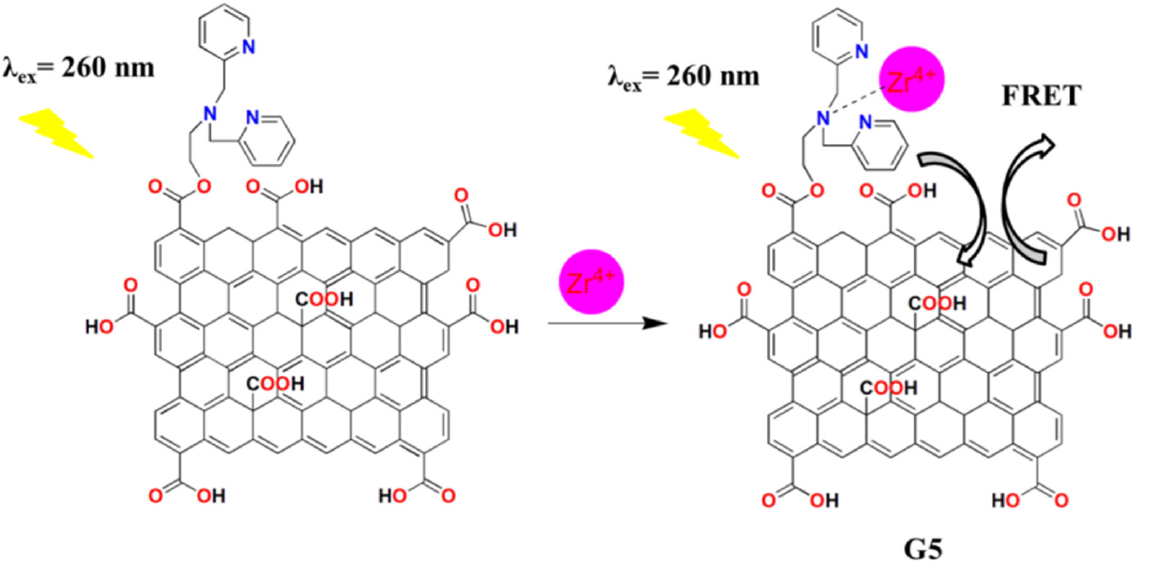
Figure 7. Proposed sensing mechanism of ( G5 ) in the presence of Zr 4+ via FRET process. Reprinted from [58] with permission from the American Chemical Society.